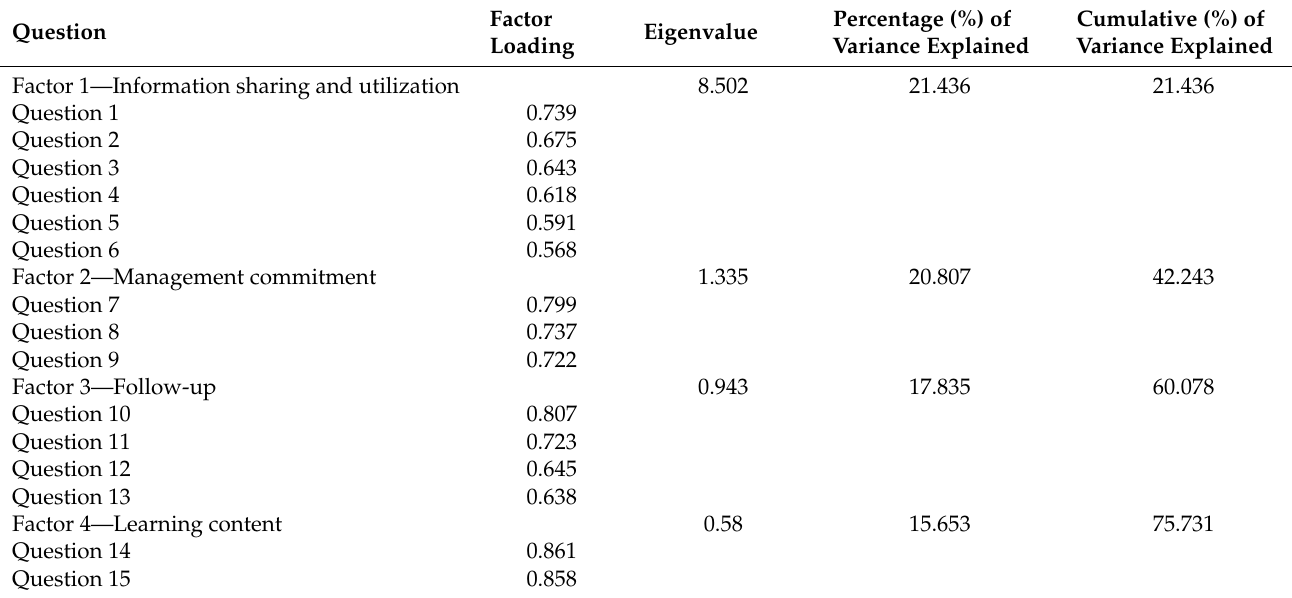
Table 5. The principal component analysis and varimax rotation of LFI factors.